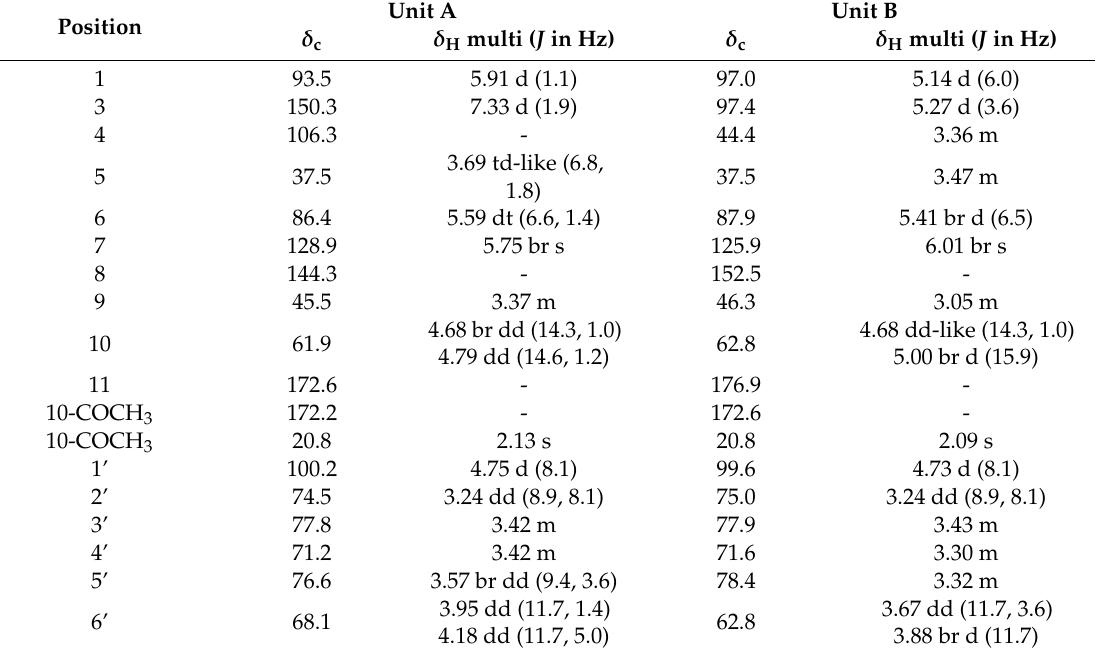
Unit A Unit B δ δ c H multi ( J in Hz)